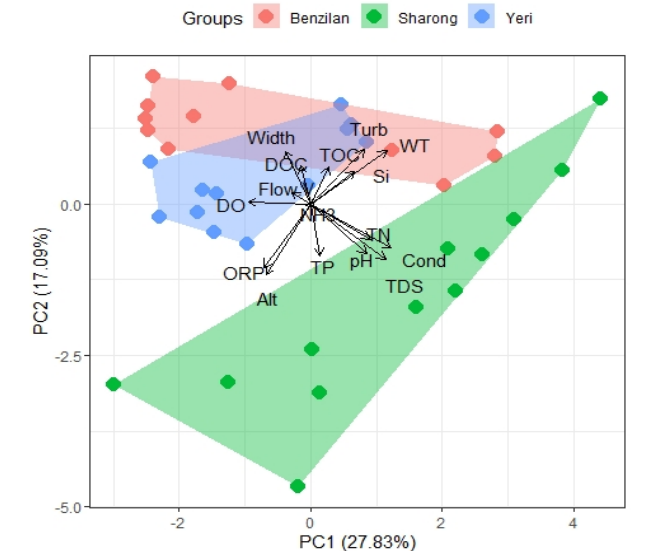
Figure 2. PCA biplot of physicochemical parameters based on the Euclidean distance for three streams. The variations captured by the first two PC axes are shown. Abbreviations: altitude (Alt), conductivity (Cond), total dissolved solids (TDS), water temperature (WT), dissolved oxygen (DO), hydrogen ion concentration (pH), oxidation reduction potential (ORP), total nitrogen (TN), ammonia (NH 3 ), total phosphorus (TP), silicon (Si), dissolved organic carbon (DOC), chlorophyll-a (Chla), total organic carbon (TOC), width of the stream (Width), flow velocity (F-v), turbidity (Turb).